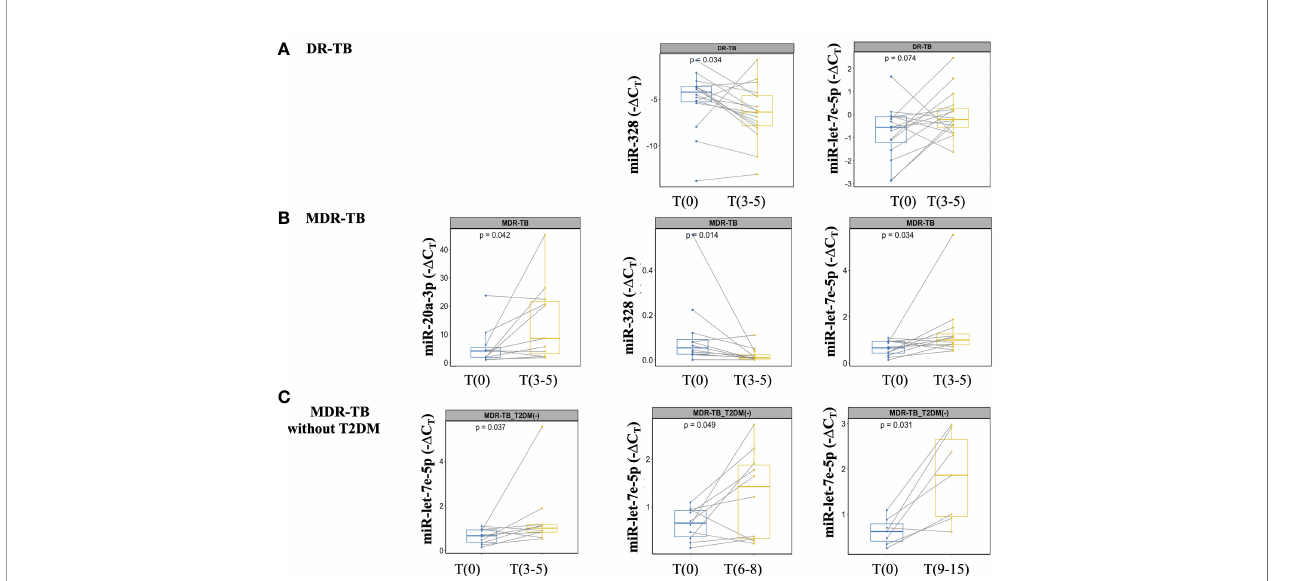
FIGURE 4 | miRNAsdetectionatthetimeof M.tuberculosis negativeculture fromDR-TB patientsandtreatmentmonitoring fromMDR-TB withoutT2DM.miRNAsexpression analyzedatT(0) andT(3-5).Thedata areexpressedas D C T ,boxplotsdepictmediansandquartiles.Linesshowtheexpressionchangefor eachpatient. (A) DR-TBpatients, (B) MDR-TBpatients, and (C) MDR-TBwithoutT2DM. Wilcoxonsigned-ranktestT(0) vs. T(3-5)or T(6-8) or T(9-15). Onlystatisticaldifferenceswithp< 0.05areshown.